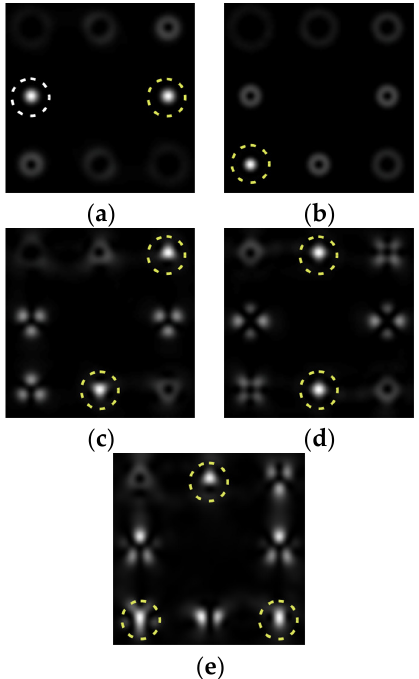
Sensors 2022 , 22 , x FOR PEER REVIEW 5 of 22 Figure 1. Eight-channel DOE, matched with optical vortices: ( a ) the form of the phase function, and ( b ) the correspondence of diffraction orders in the focal plane.